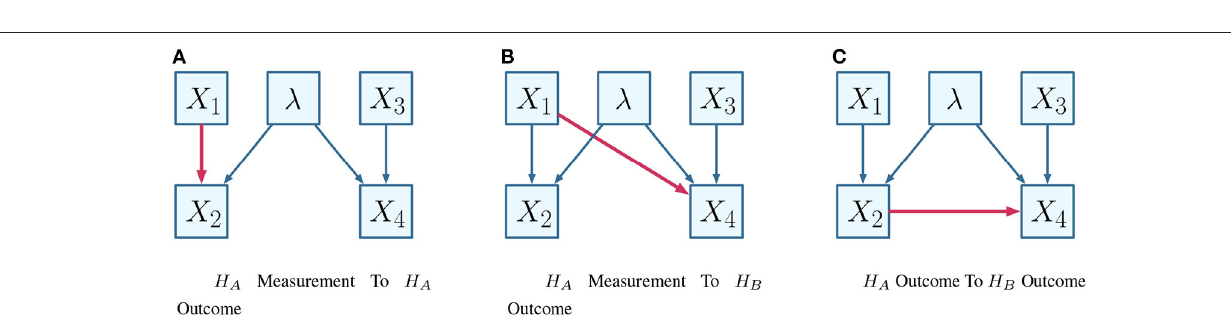
FIGURE 5 | Alternative causal influences. (A) H A measurement to H A outcome. (B) H A measurement to H B outcome. (C) H A outcome to H B